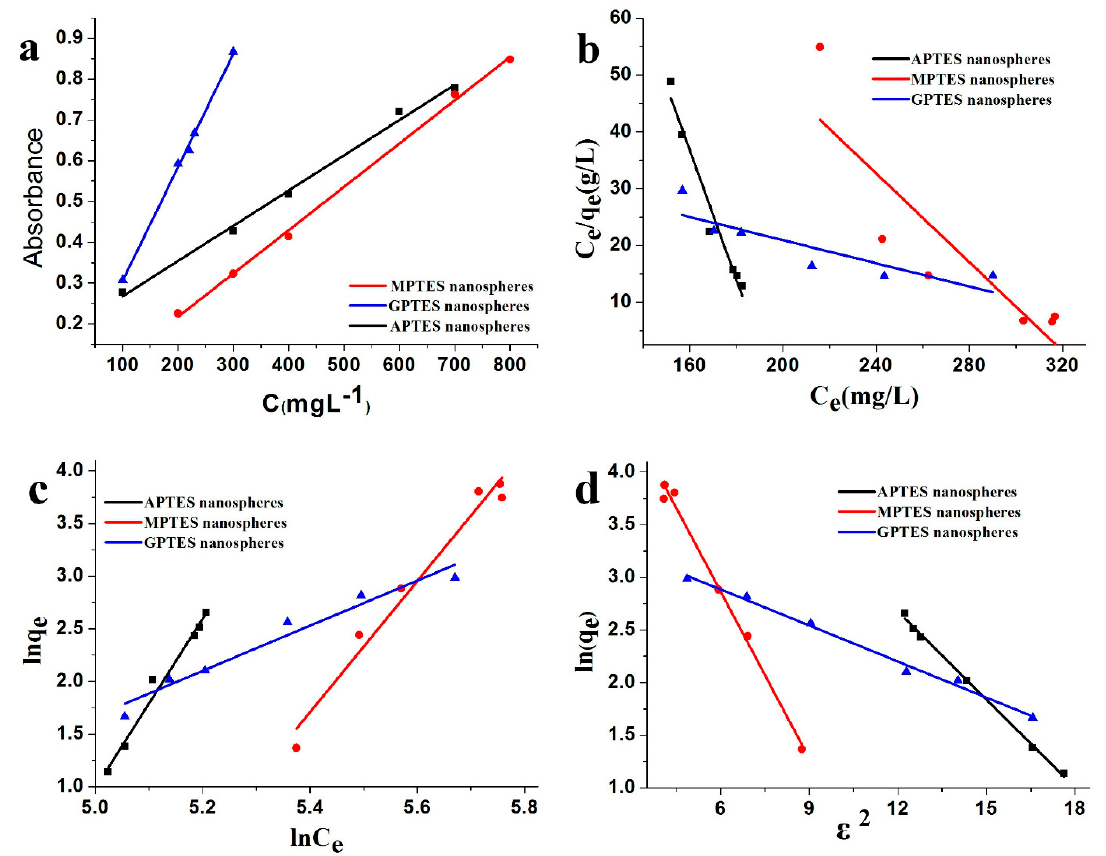
Figure 6. ( a ) Beer–Lambert standard curve of modified SiO 2 nanospheres; ( b ) Langmuir adsorption isotherm and ( c ) Freundlich adsorption isotherm, and ( d ) Dubinin–Radushkevich adsorption isotherm of leather adsorption of modified SiO 2 nanospheres. Table 4. Correlation fitting coefficient of SiO 2 nanospheres modified by leather adsorption.